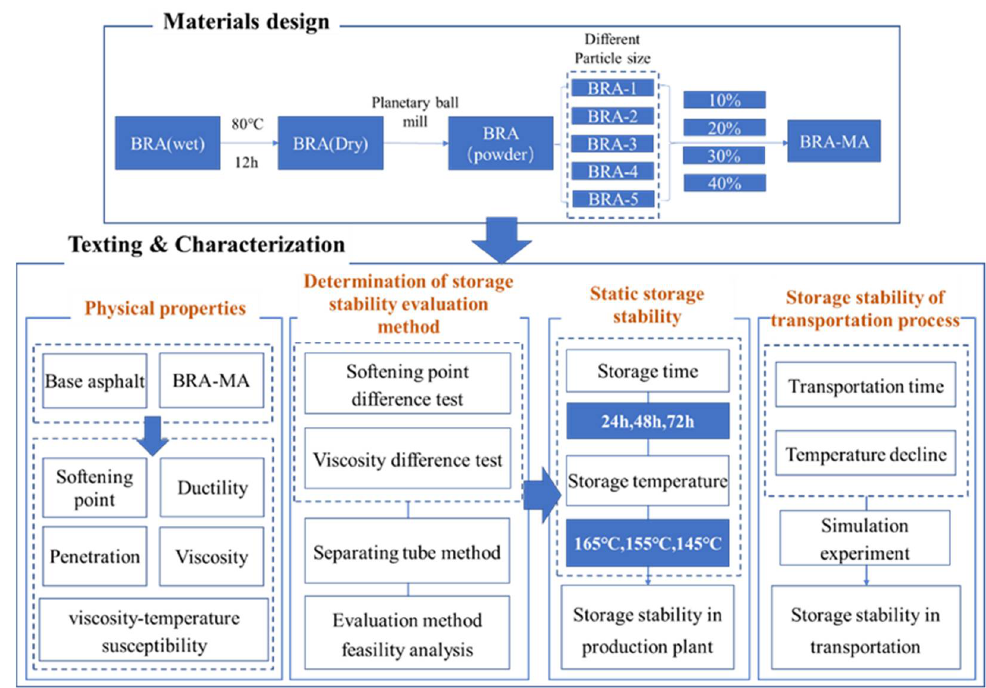
Figure 3. Outline of this